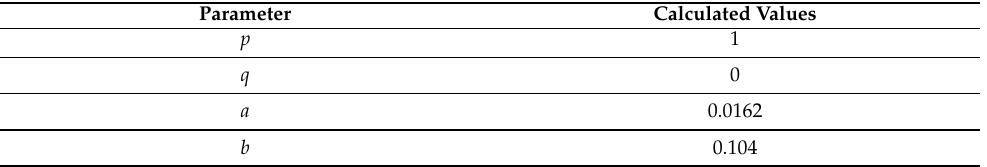
Figure 9. Parameter values evolution by adaptive block. Fitted values roughly coincide with the actual ones in the dataset. Table 3. Target parameter values obtained from Engel [28] (Data source: https://apps.dtic.mil/sti/ citations/AD0298786, last visited 26 June